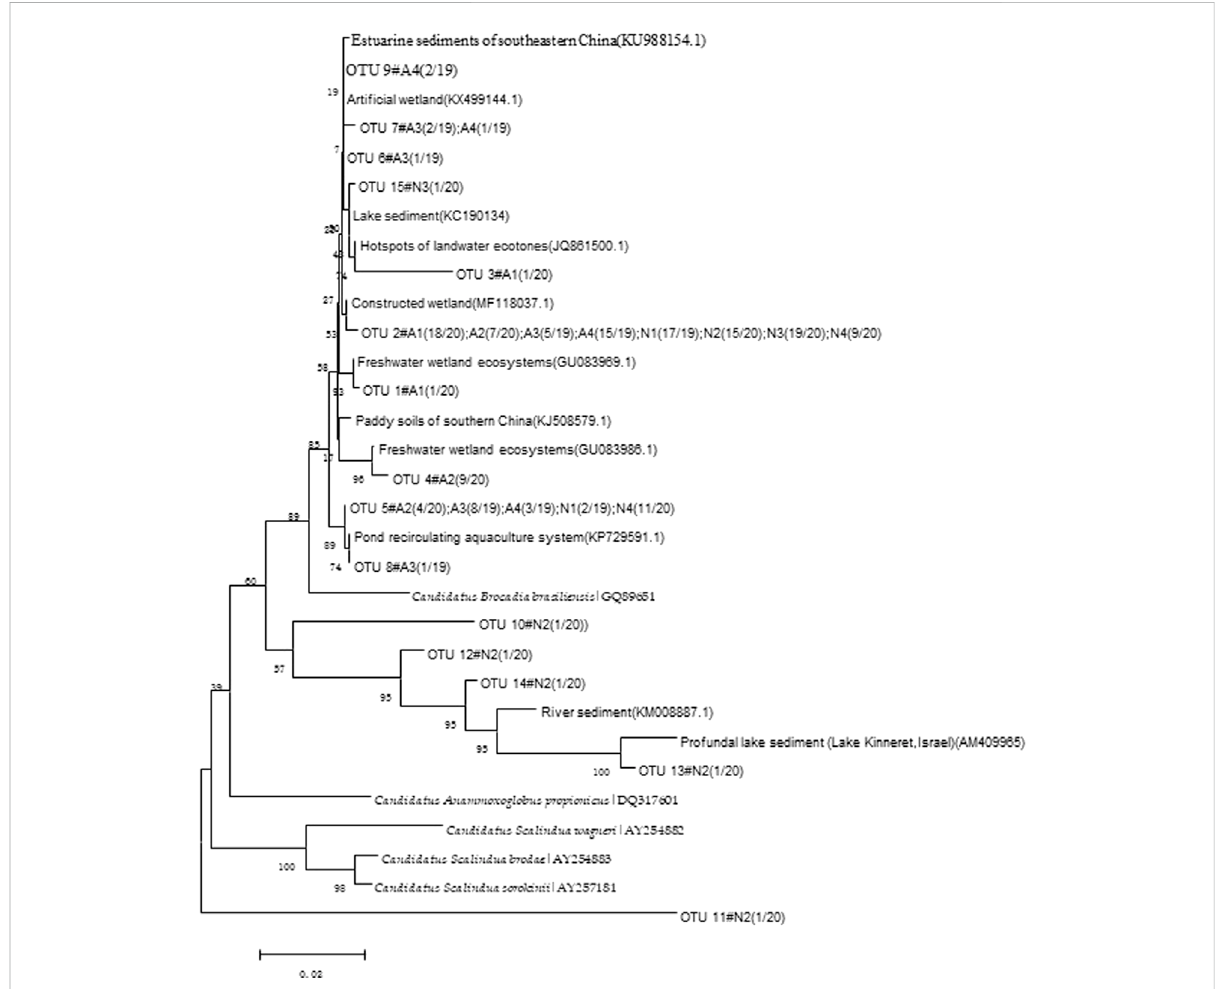
FIGURE 3 The Anammox bacterial 16S rRNA genes in the denitrifying and anammox